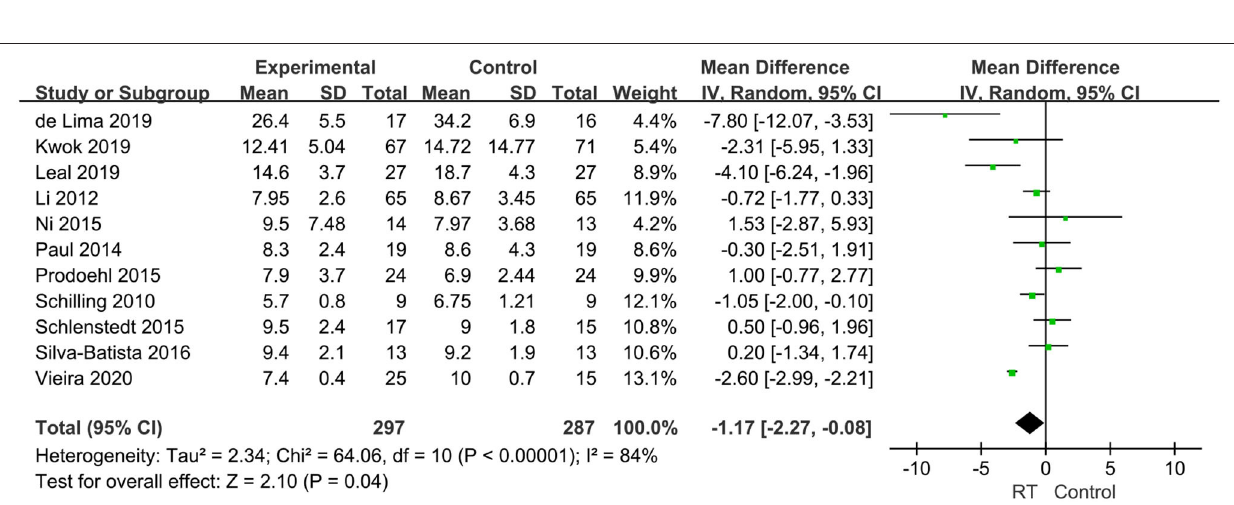
FIGURE 7 | Forest plots of the effects of lower limb RT on gait performance—timed-up-and-go-test in PD. CI, confidence interval.